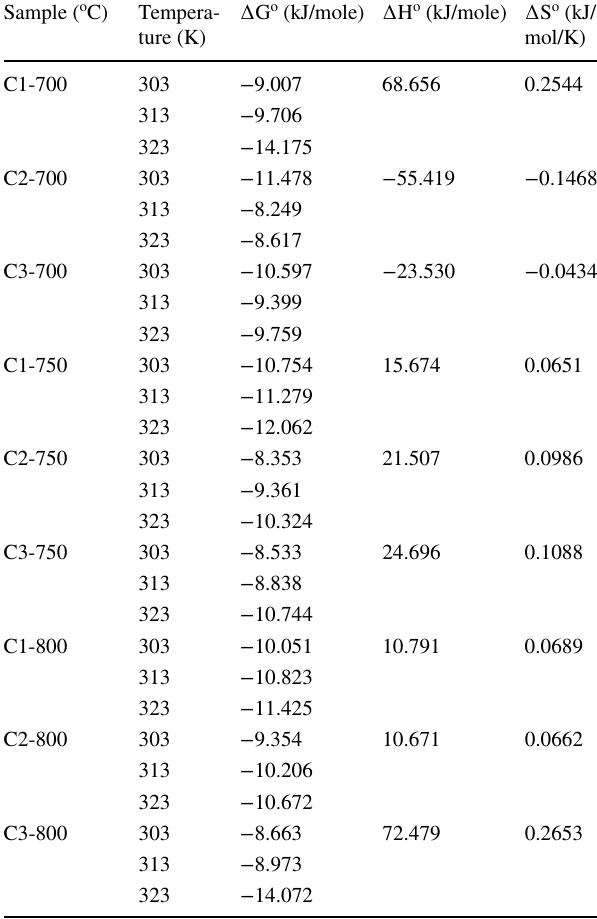
Table 6 Thermodynamic parameters of cadmium adsorption for all